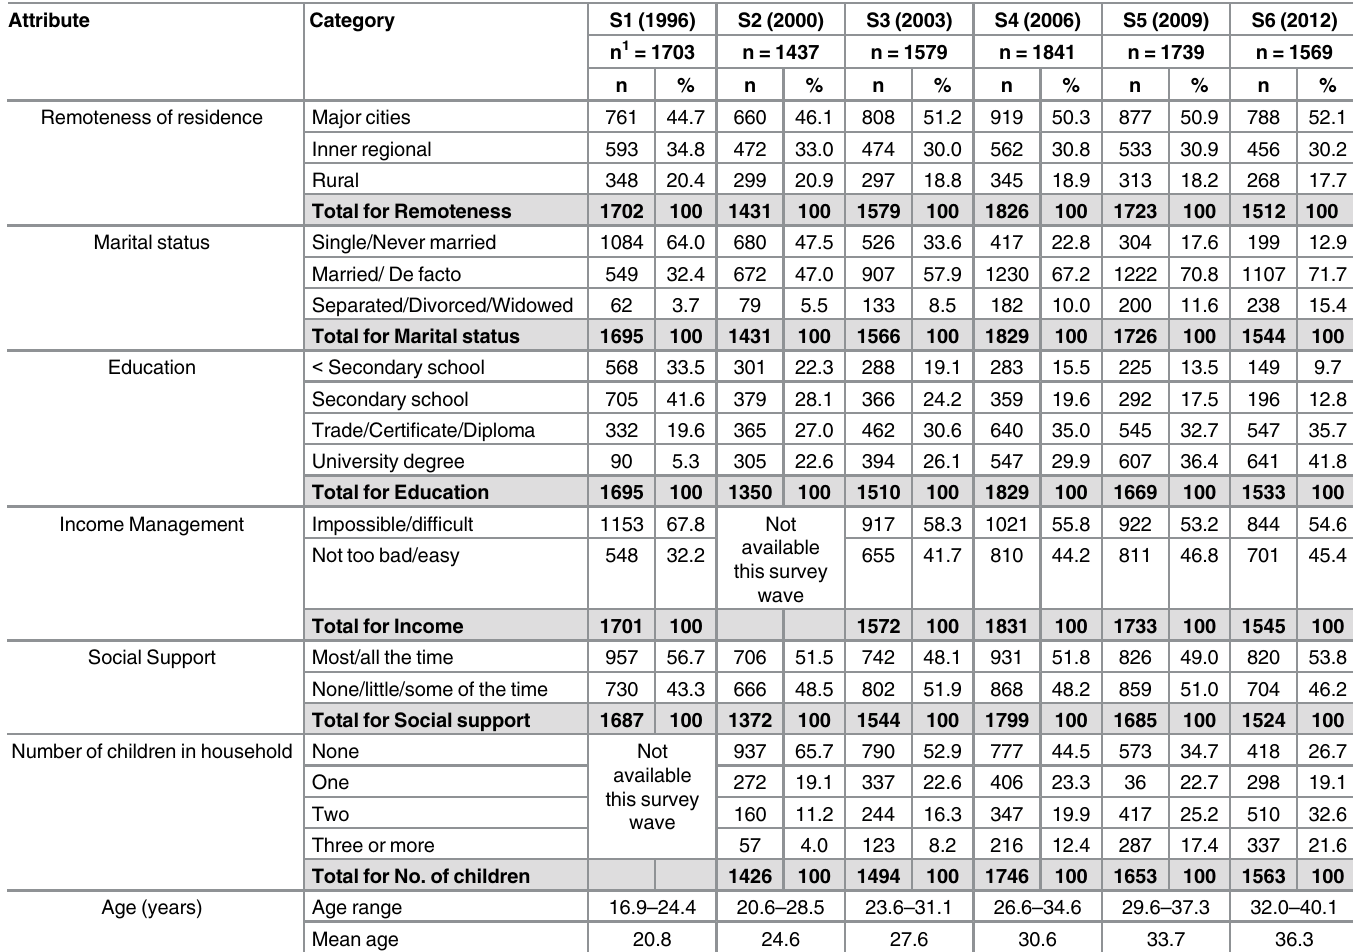
Table 1. Socio-demographic characteristics of women with a lifetime history of IPV across six survey waves (S1-S6) of the ALSWH.